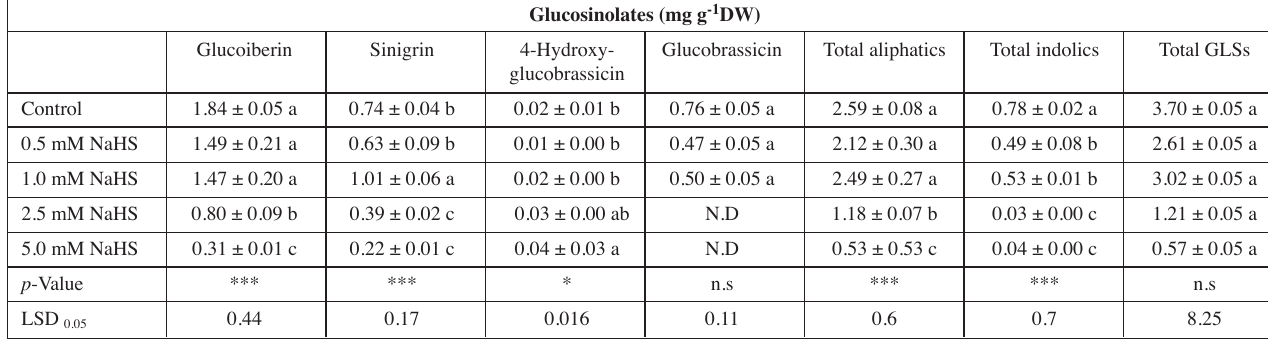
Tab. 4: Effects of different doses of NaHS on glucosinolate